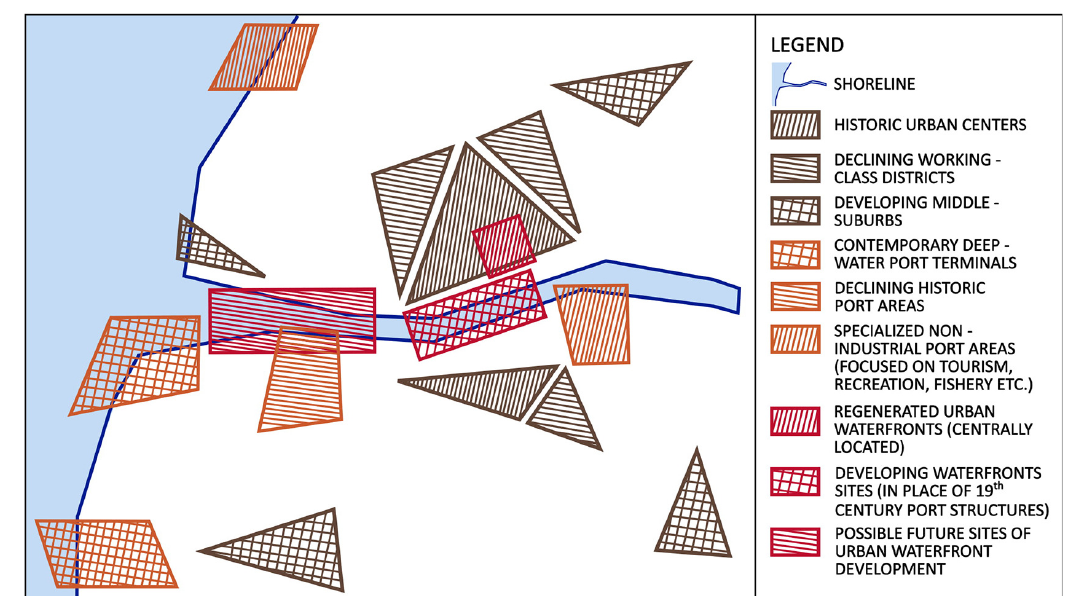
Figure 2. Rotterdam: The hypothetical diversification of port‐city area within the porous port region. Source: Based on the interpretation of a drawing by Meyer (1999).